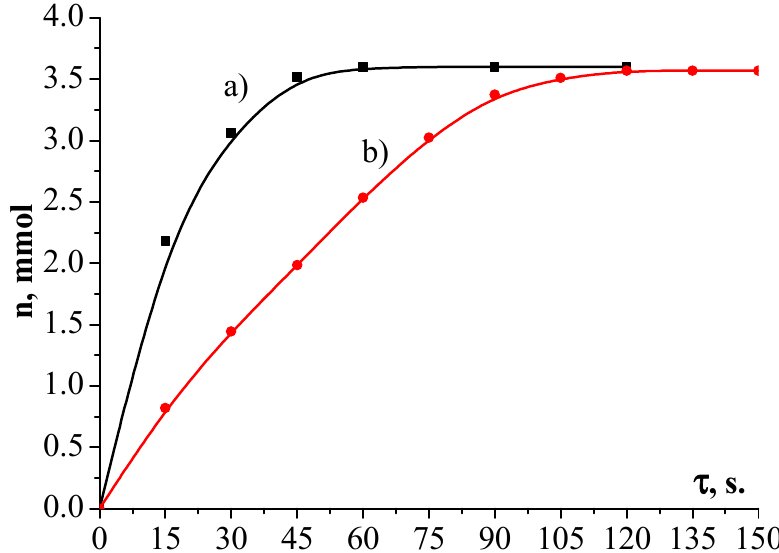
Figure 8. Kinetic curves of hydrogen uptake in the 4-nitroaniline hydrogenation in aqueous 2-propanol (0.68 mol fraction). T = 298K, m (cat) = 0.30 ± 0.05 g., m (NA) = 0.50 ± 0.05 g. ( a ) 5 wt.% Pd/SiO 2 - C 3 H 6 -(30%)NH 2 ; ( b ) 5 wt.% Pd/SiO 2 -C 3 H 6 -(10%)NH 2 .